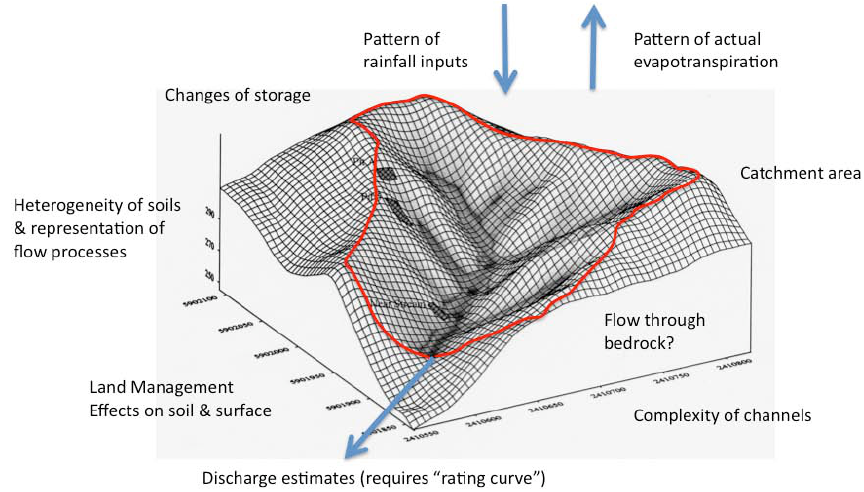
Fig. 1. Potential sources of epistemic error in measuring and modelling catchment